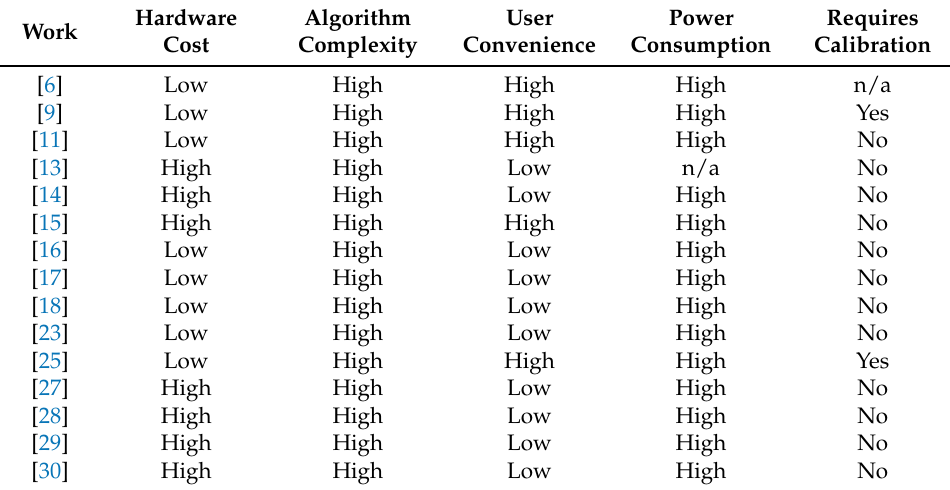
Table 2. Comparison of existing WiFi-based